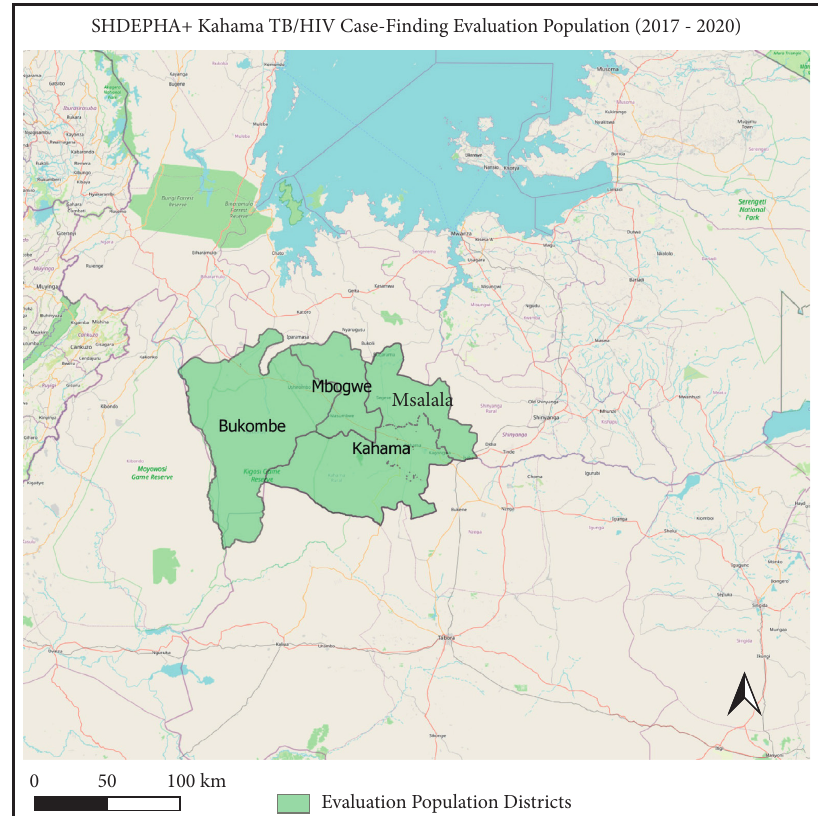
Figure 1: TB/HIV case-finding intervention area (2017–2020).